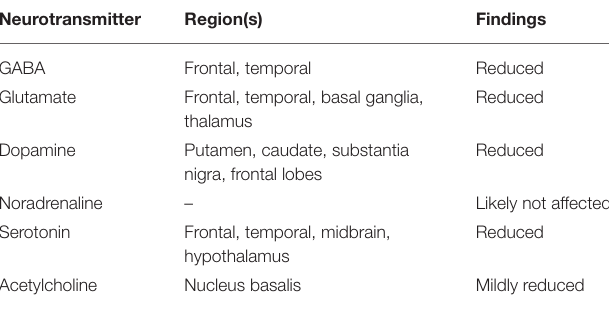
TABLE 1 | Neurotransmitter deficits in frontotemporal